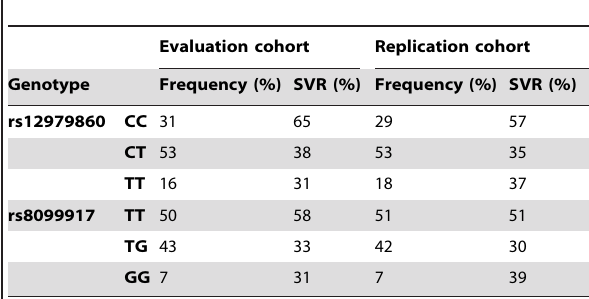
Table 2. Genotype frequencies and sustained